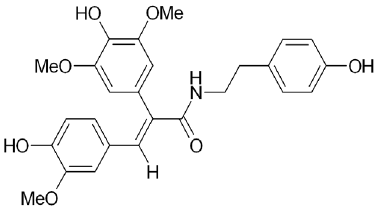
Figure 1. The chemical structure of FLZ.